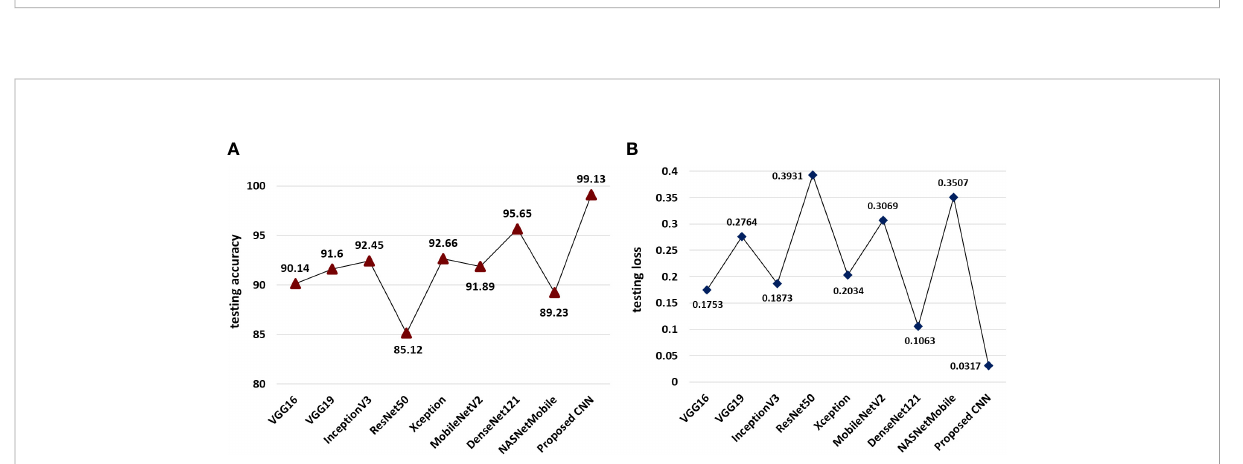
FIGURE 7 Comparative performance of the proposed model and pretrained models (A) models wise classi fi cation accuracies on test data and (B) model- wise testing